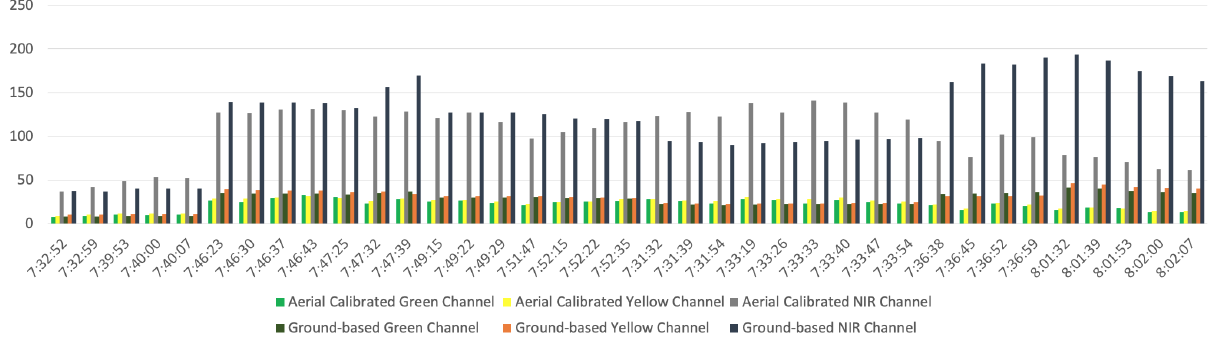
Figure 18. Comparison of aerial and ground-based spectrometer green, yellow, and NIR channel data from target plant during morning cycles after